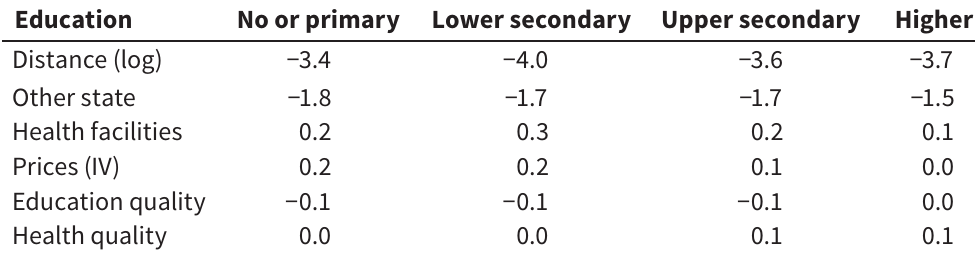
Elasticities of significant covariates by